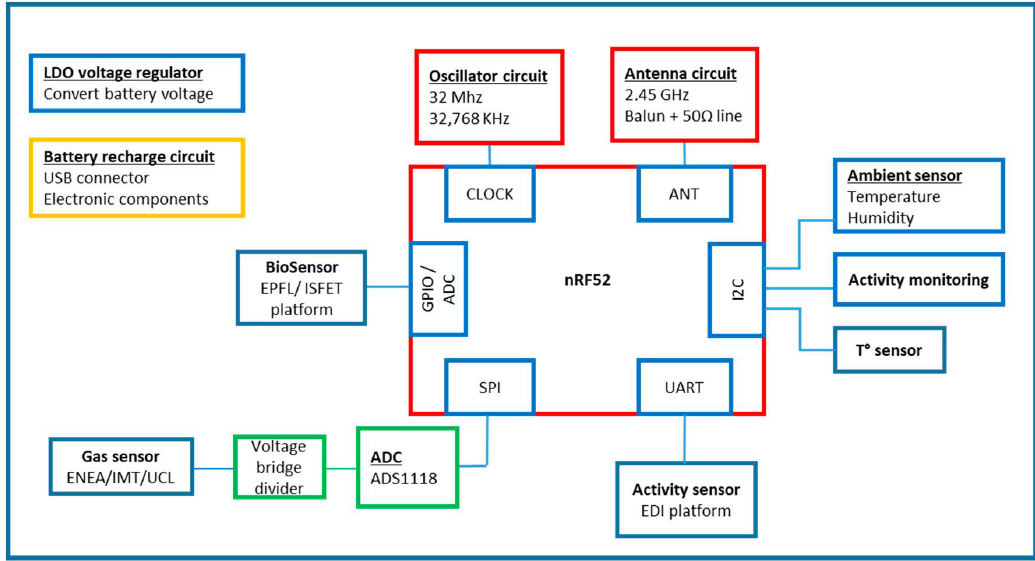
Figure 2. E lectronic board (red rectangle) developed by CEA-LETI with communication protocols Serial Peripheral Inter- face (SPI), Universal Asynchronous Reception and Transmission (UART), Inter-integrated-circuit (I2C), General Purpose Input/Output (GPIO) converter, Analog to Digital Converter (ADC).